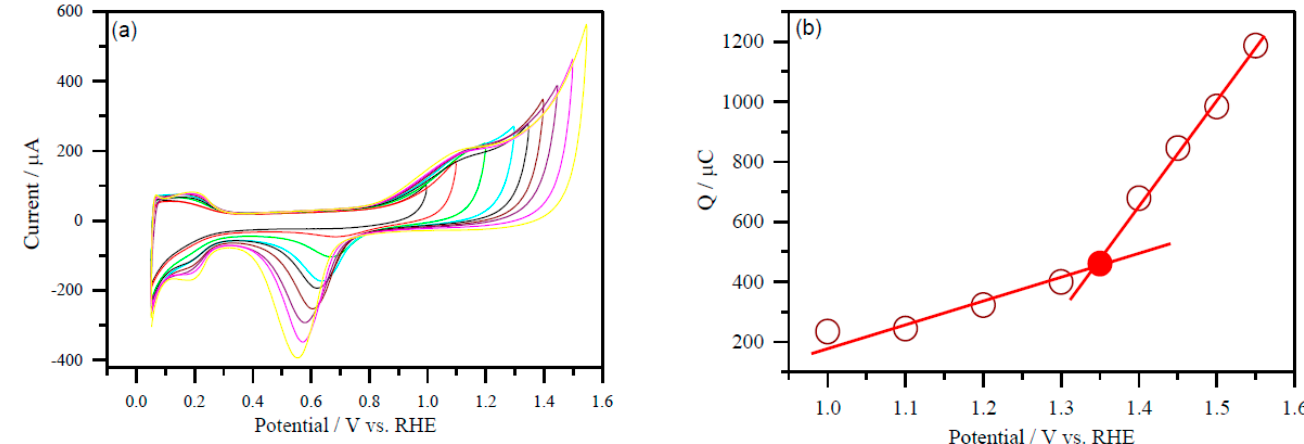
Figure 4. A representative plot to determine the active surface area of the Pd and PdNi (50:50) carbon supported electrocata- lysts. ( a ) CVs with different upper potential limits at a scan rate of 50 mV s − 1 ; PdNi/C 50:50 ( b ) the integrated charge as a function of the upper potential limit. The value of the charge of the inflexion point (colored) was used to determine the ESA. CVs were performed in Ar-purged 0.5 M H 2 SO 4 solution.